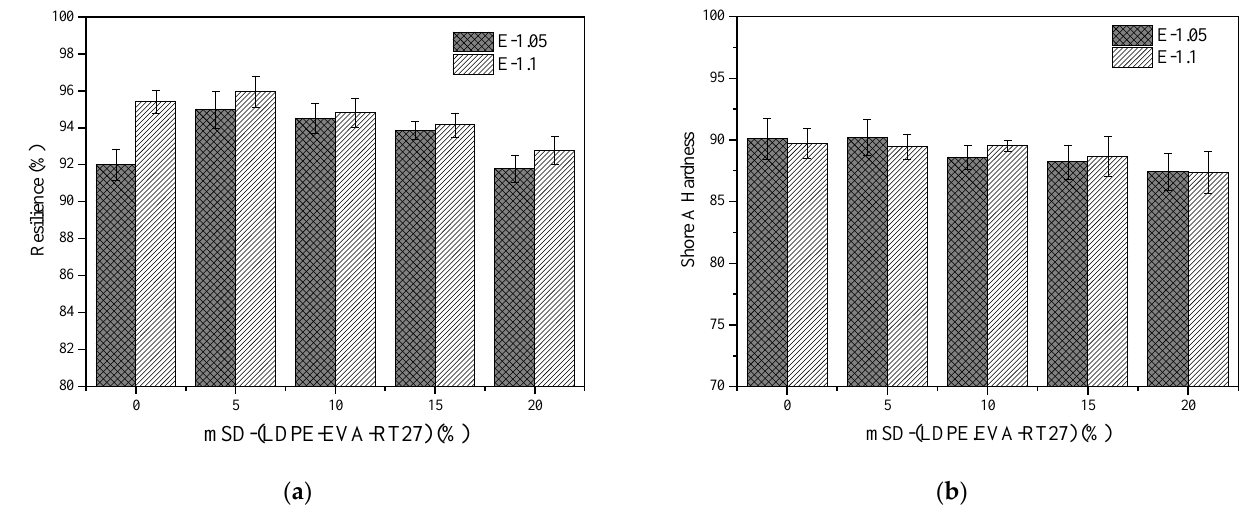
Figure 9. Resilience ( a ) and Shore A hardness ( b ) of the elastomers with mSD-(LDPE·EVA-RT27).